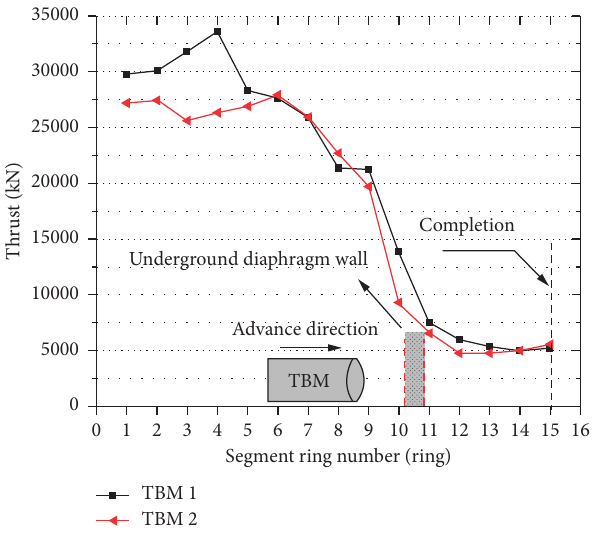
Figure 12: Thrust of the last 15 rings during shield recovery.